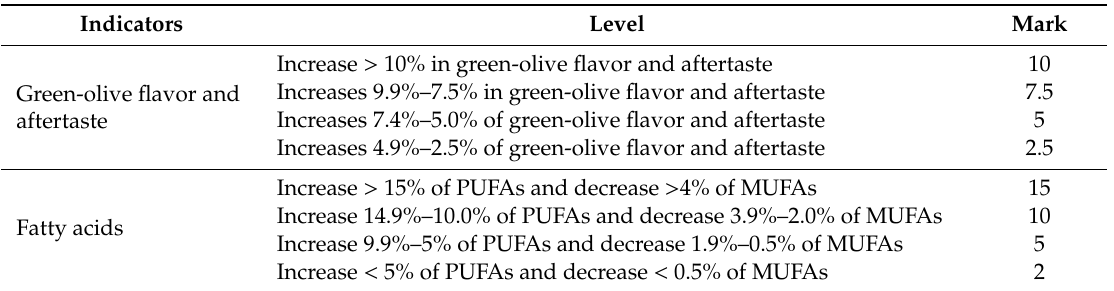
Table 2. Indicators, levels, and marks of the hydroSOS quality index in table olives. MUFAs, mono- unsaturated fatty acids; PUFAs, poly-unsaturated fatty